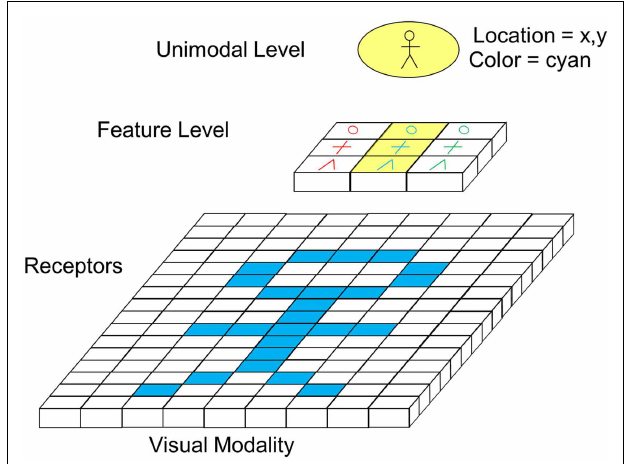
FIGURE 5 | Feedforward visual information processing from receptor level to unimodal level (excitatory forward connections not